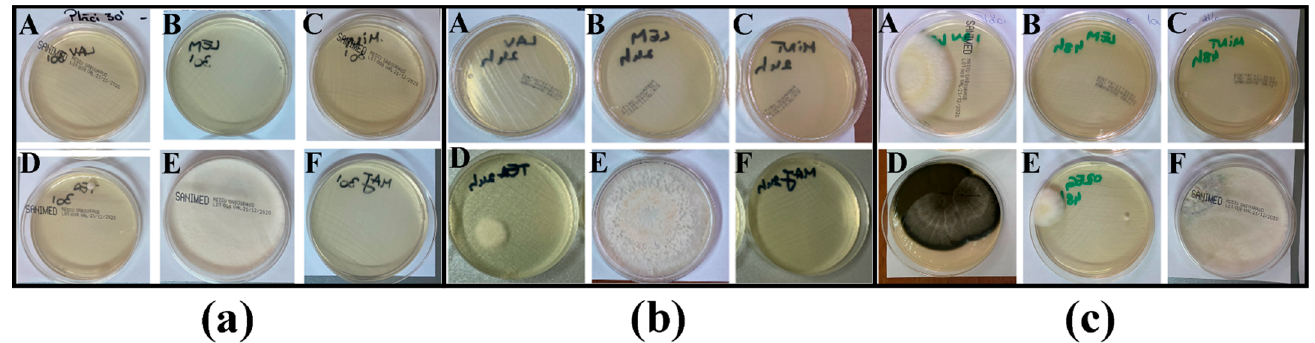
Figure 4. The plates read on day 14 of incubation: the samples at ( a ) 30 min, ( b ) 24 h and ( c ) 48 h. Figure 5a–c show the plates, as read on day 30 of the incubation. The developed col- onies became macroscopically visible after between 20 days to 25 days of incubation. Figure 5. The plates read on day 30 of incubation: samples at ( a ) 30 min, ( b ) 24 h and ( c ) 48 h. The results, obtained after the samples from the examined areas were examinedat 30 min, 24 h and 48 h following the application of the EOs, are presented in Table 3. The existing difference was due to the duration of the effect that they had on certain types of fungi as shown on Table 4. It is evident that some EOs (e.g., Lavandula angustifolia, Melaleuca alternifolia, Marjoram, Origanum vulgare ) inhibited the action of some fungal genera up to a period of 22 days, whereas on others the effect lasted for a period of at least 30 to 32 days (Table